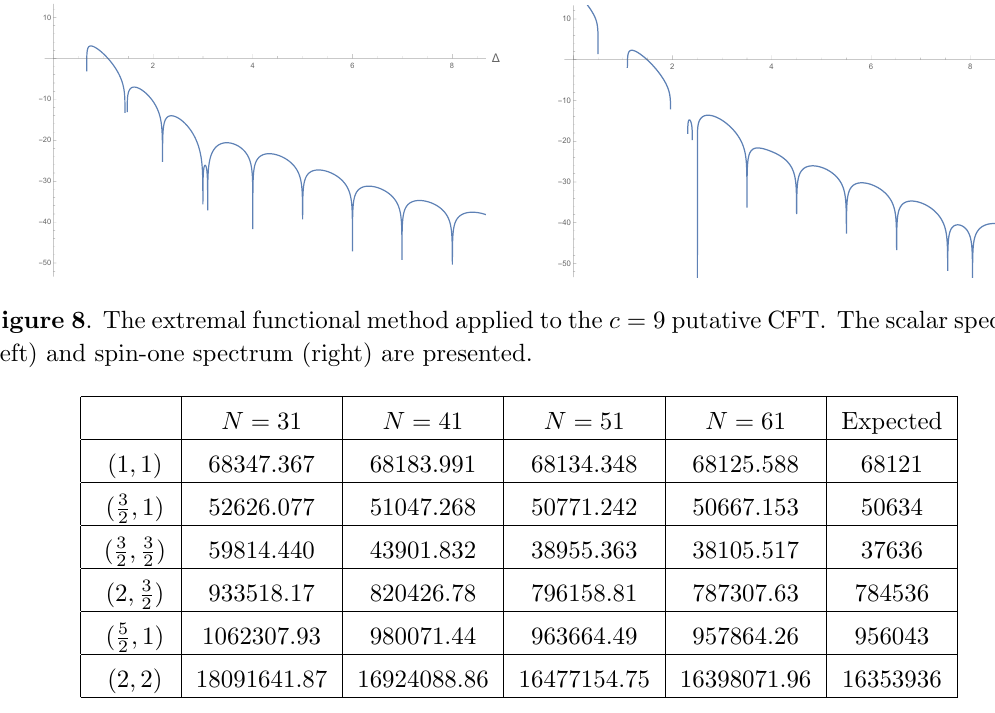
Table 3 . The maximum value of degeneracies for low-lying states in a putative N = (1 ; 1) CFT at c =